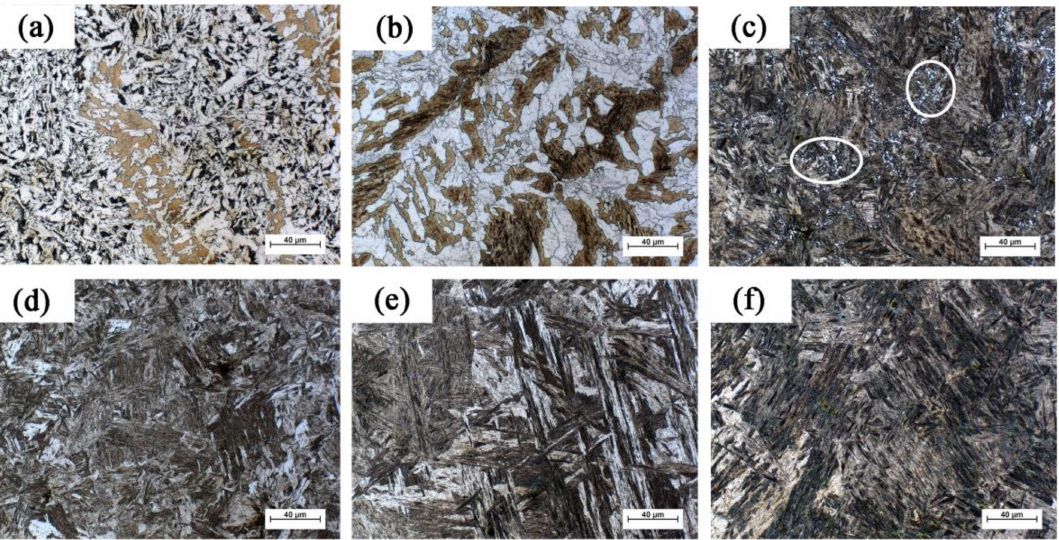
Figure 9. The microstructures near the fracture surface of VH steel fractured at 600~1200 ◦ C with a strain rate of 10 − 3 s − 1 : ( a ) 600 ◦ C; ( b ) 700 ◦ C; ( c ) 800 ◦ C; ( d ) 900 ◦ C; ( e ) 1000 ◦ C; ( f ) 1200 ◦ C.